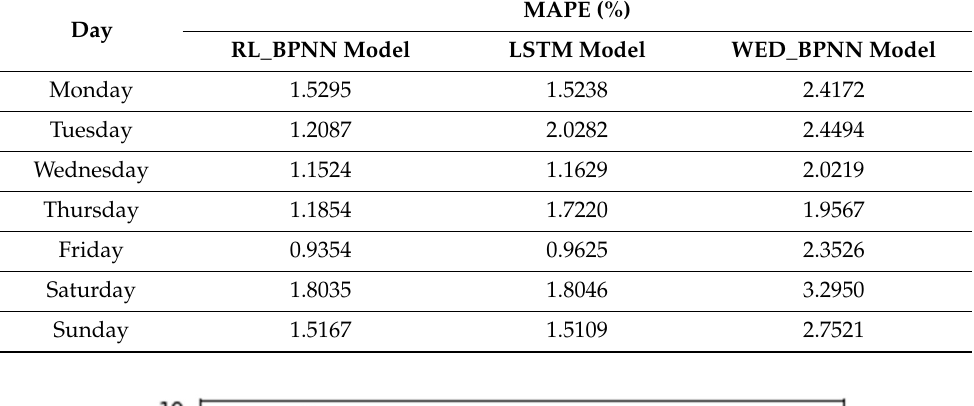
Figure 13. MAPE of the models by day of week.